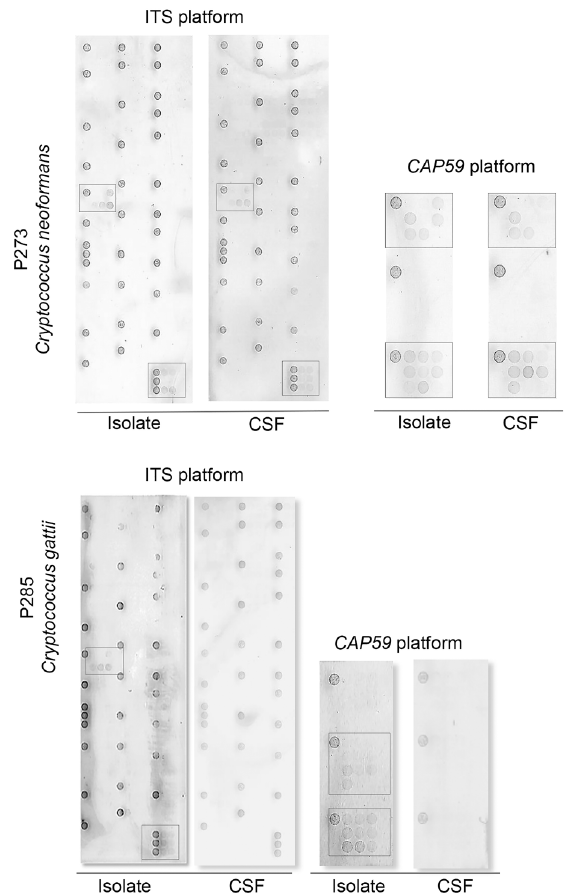
Figure 3. Representative results of Cryptococcus identi fi cation by DNA microarray platforms. P273 cerebral spinal fl uid (CSF) sample and cultured isolate of C. neoformans tested by ITS and CAP59 platforms showing positive results, and P285 CSF sample and cultured isolated of C. gattii tested by ITS and CAP59 platforms showing positive results only for DNA extraction obtained from cultured